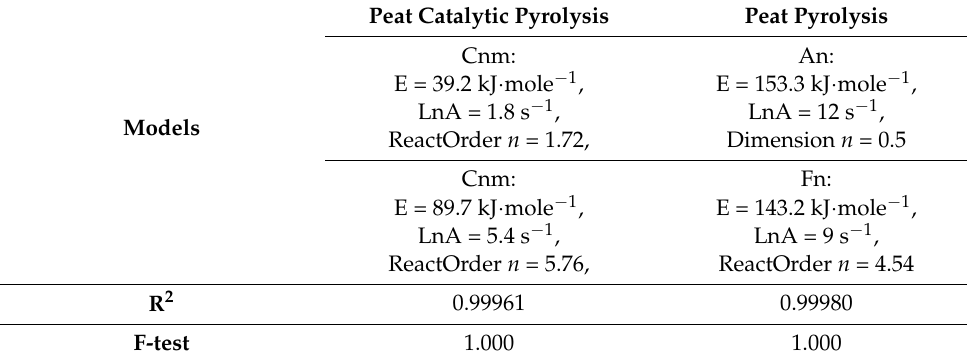
Table 4. Kinetic parameters of peat model pyrolysis